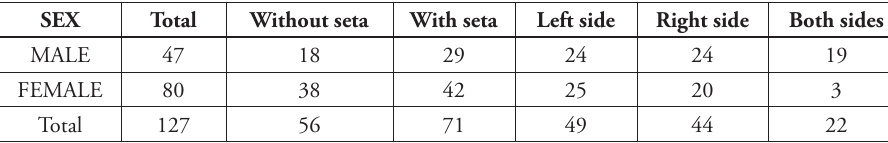
Table 1. Specimen strobilate setae presence or absence